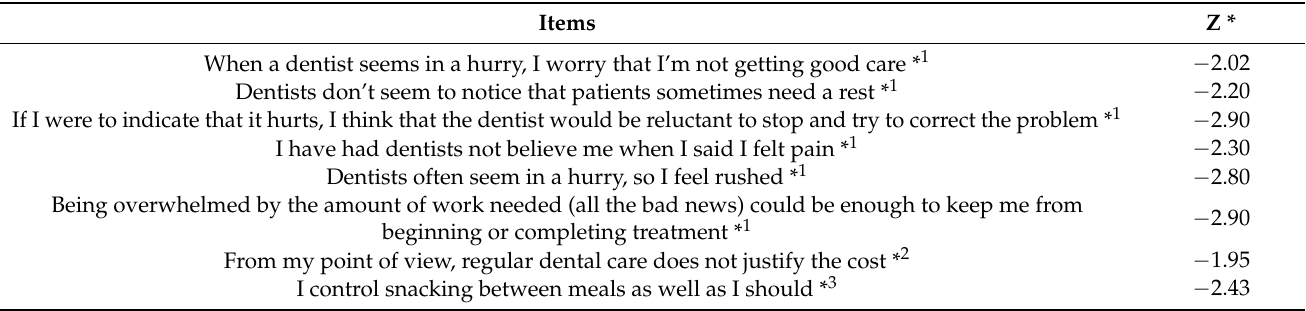
Table A1. The least different items between males and females/the items with the smallest differences between the two genders. Items Z *